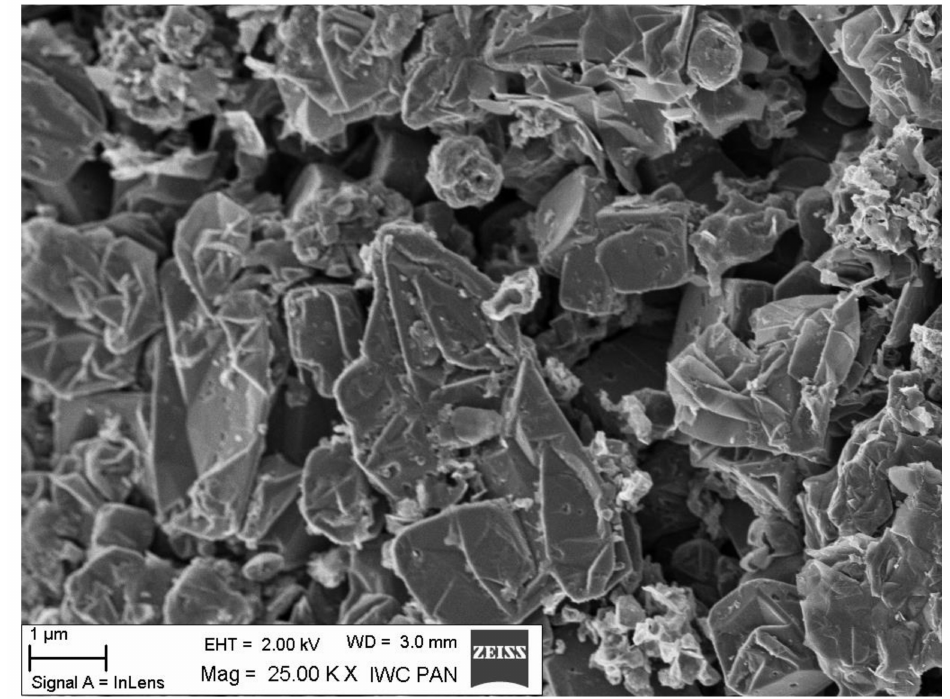
Figure 5. SEM image of carbon material C-SB obtained from NaHCO 3 .